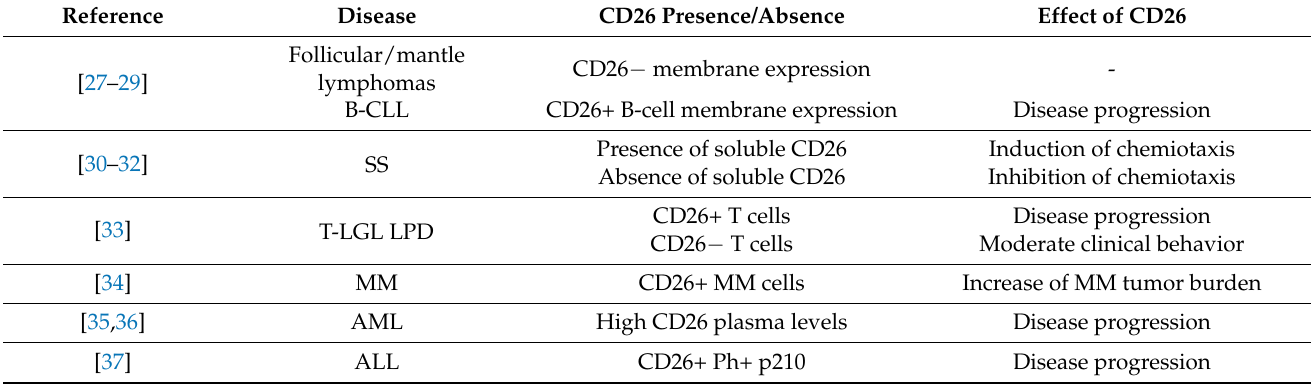
Table 2. Summary of clinical and biological studies that investigated the role of CD26 (expressed as soluble form or as surface glycoprotein) in different hematological